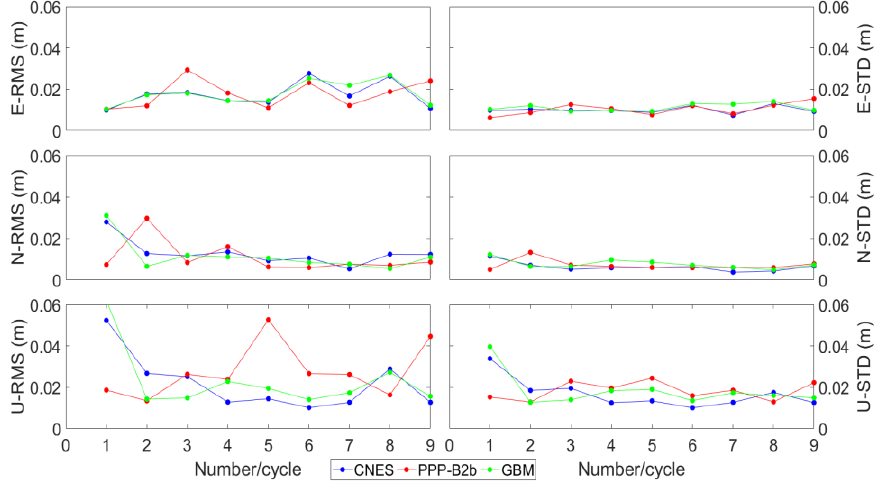
Figure 14. The STD and RMS values of positioning accuracy for JFNG station.